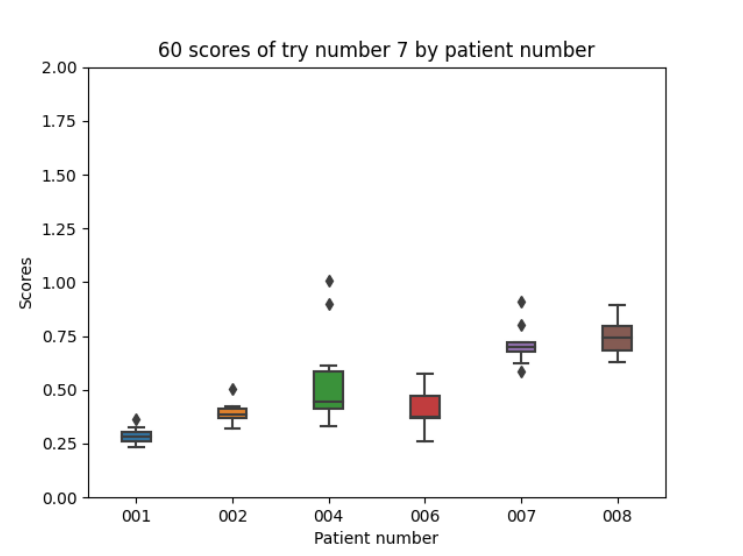
Figure 18. Experiment 7 boxplot scores, from 10 executions for each patient and